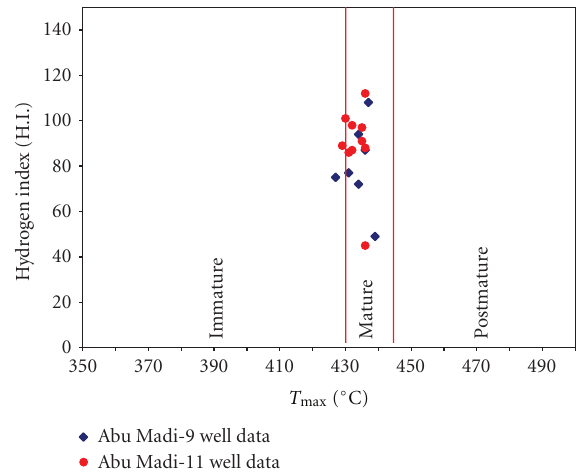
Figure 4: Plot of T max versus H.I. for the analyzed samples from Abu Madi-9 and Abu Madi-11 wells well.